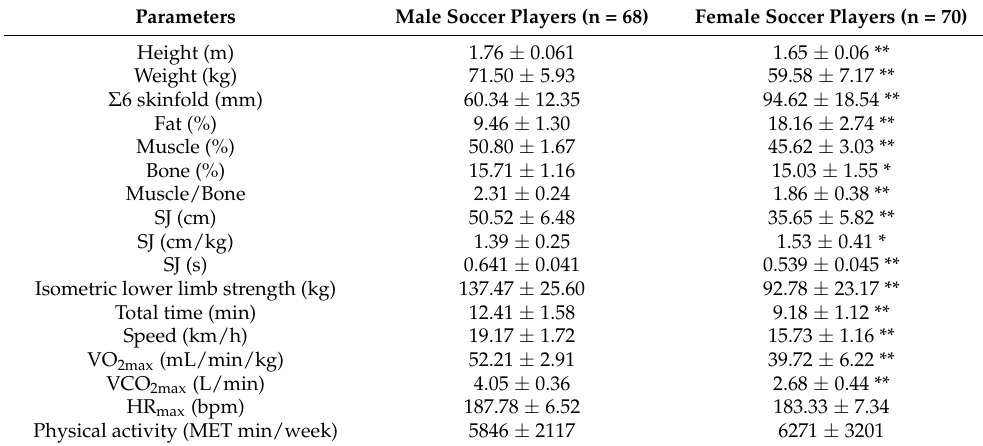
Table 2. Anthropometry, body composition, physical condition and physical activity of the participants. Parameters